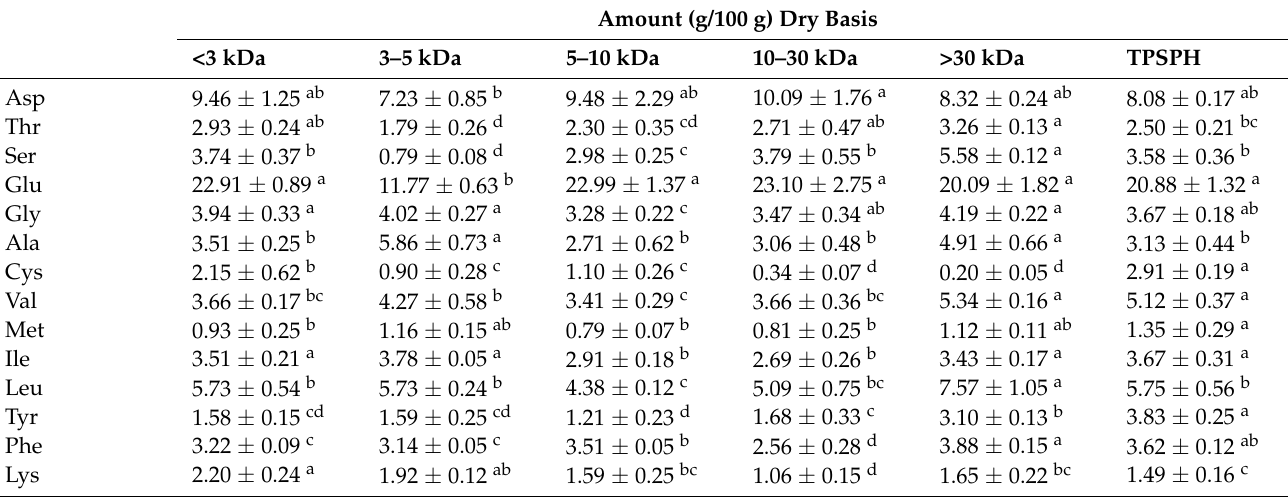
Table 1. Amino acid compositions of TPSPH and five